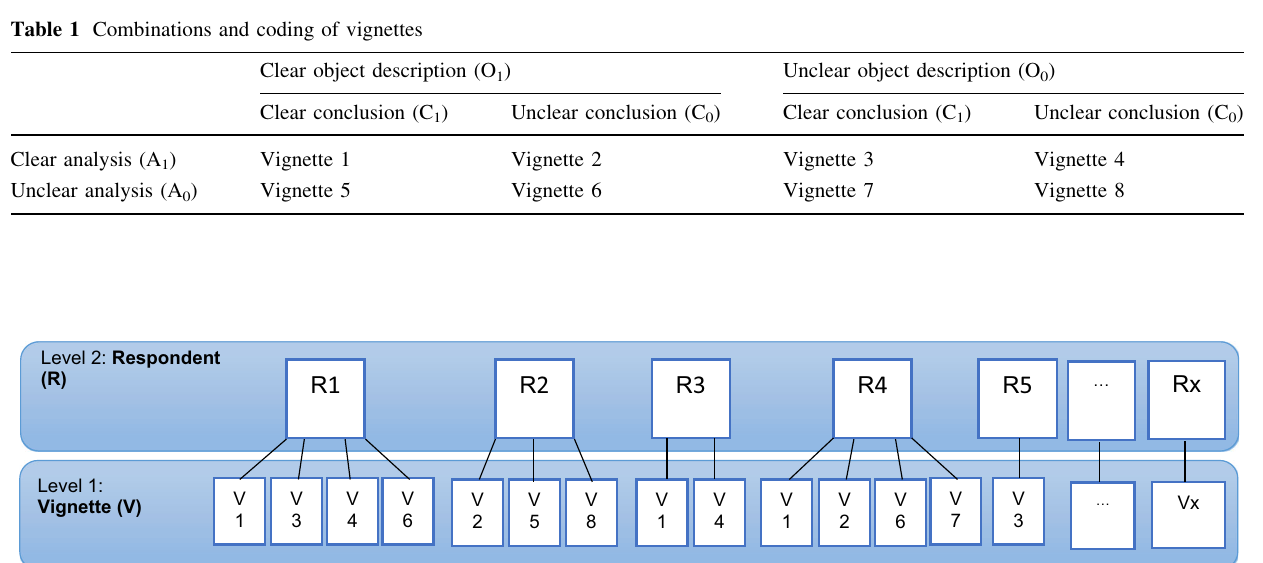
Fig. 1 Distribution of the